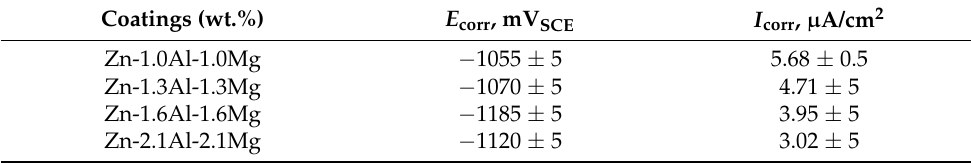
Table 2. Corrosion potential and corrosion current density of experimental coating. Coatings (wt.%)